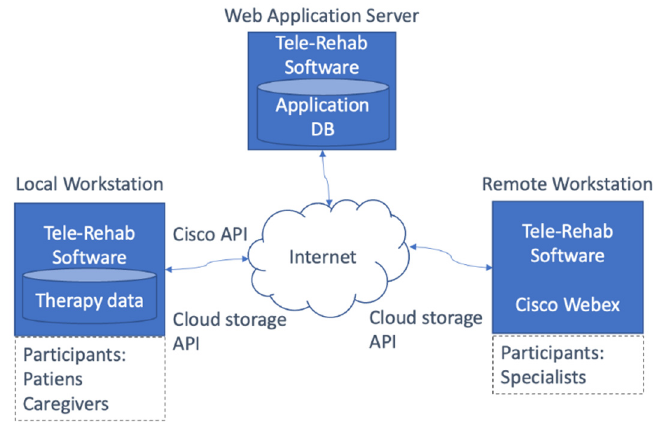
Figure 2. The telerehabilitation system architecture [54].